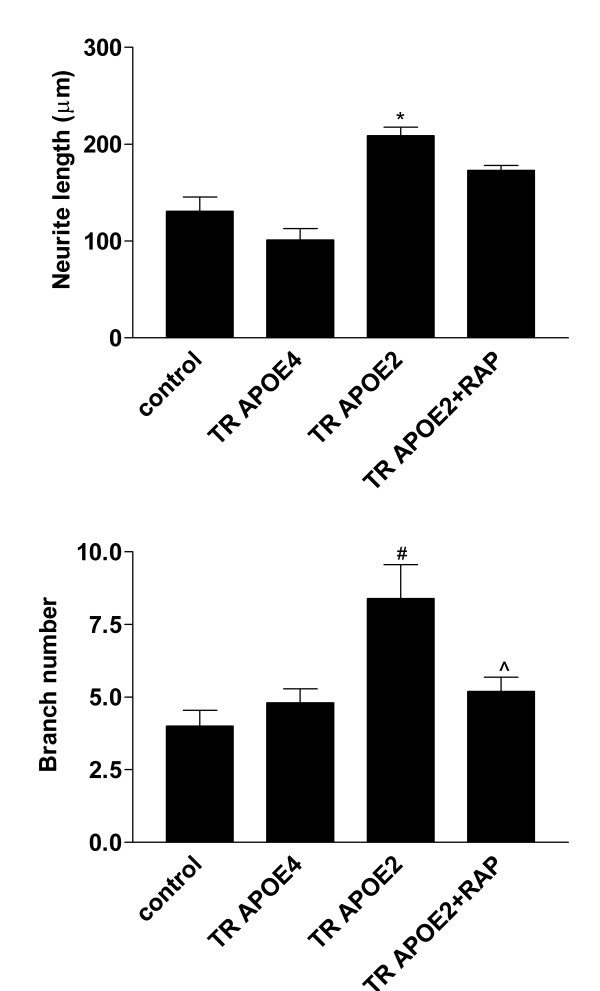
Neurite outgrowth following incubation with astrocyte conditioned medium (CM). CM was generated from TR APOE primary astrocytic cultures and collected after 72 hours. Primary wt neurons were treated with astrocyte CM (50% of total volume) or 100% Neurobasal medium (control). For RAP treatment, neurons were preincubated with 200 nM RAP for 2 hrs prior to the addition of CM. After 48 hours, neurons were immunostained with anti-MAP2 antibody (1:500) and examined with a confocal microscope using LaserSharp software (BioRad). Five or more MAP2-stained neurons were randomly selected and dendrite length (A) and branch number (B) determined by Neurolucida. Data are expressed as mean length or branch number ± SEM (n = 5). One-way ANOVA for neurite length (A) had P < 0.0001 and Bonferroni-corrected repeated pair analysis had *P < 0.001 for TR APOE2 vs. control but P > 0.05 for TR APOE4 or TR APOE2+RAP vs. control. For branch number (B), one-way ANOVA had P < 0.05 and Bonferroni-corrected repeated pair analysis had #P < 0.01 for TR APOE2 vs. control, P > 0.05 for TR APOE4 or TR APOE2+RAP vs. control, and ^P < 0.05 for TR APOE2 vs. TR APOE2+RAP.